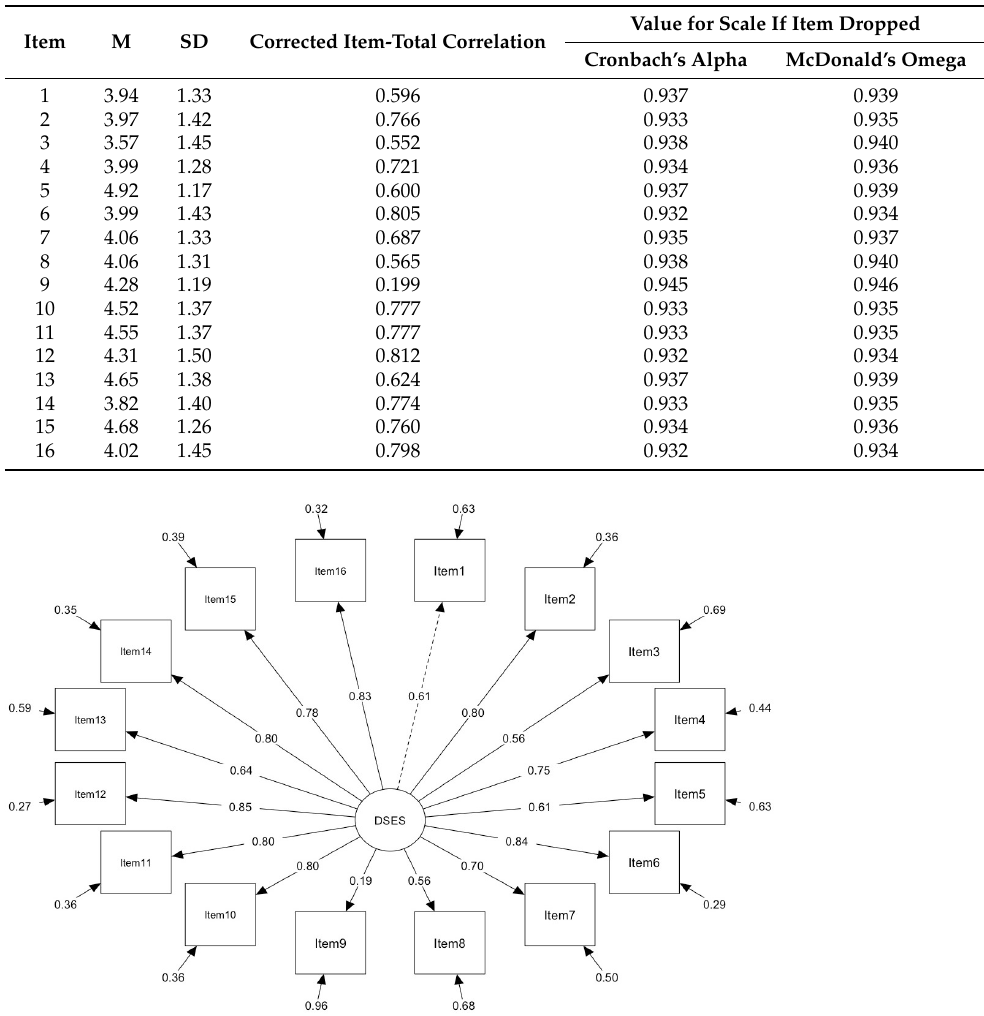
Table 6. Reliability statistic fors DSES items in Sample 2.